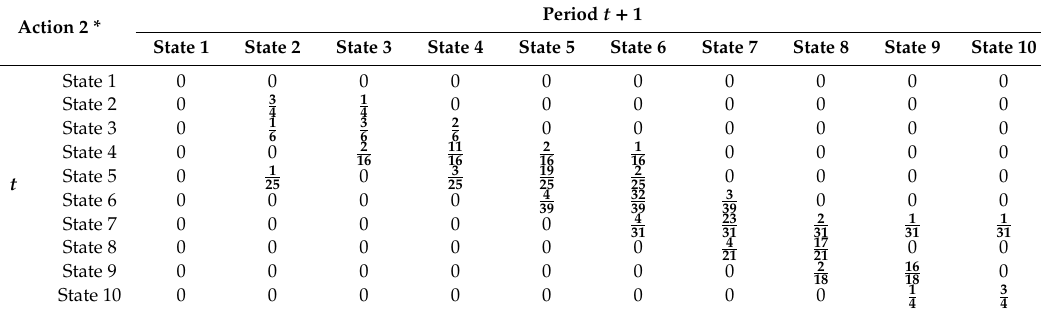
Table A2. Transitions probability matrix of action 2.